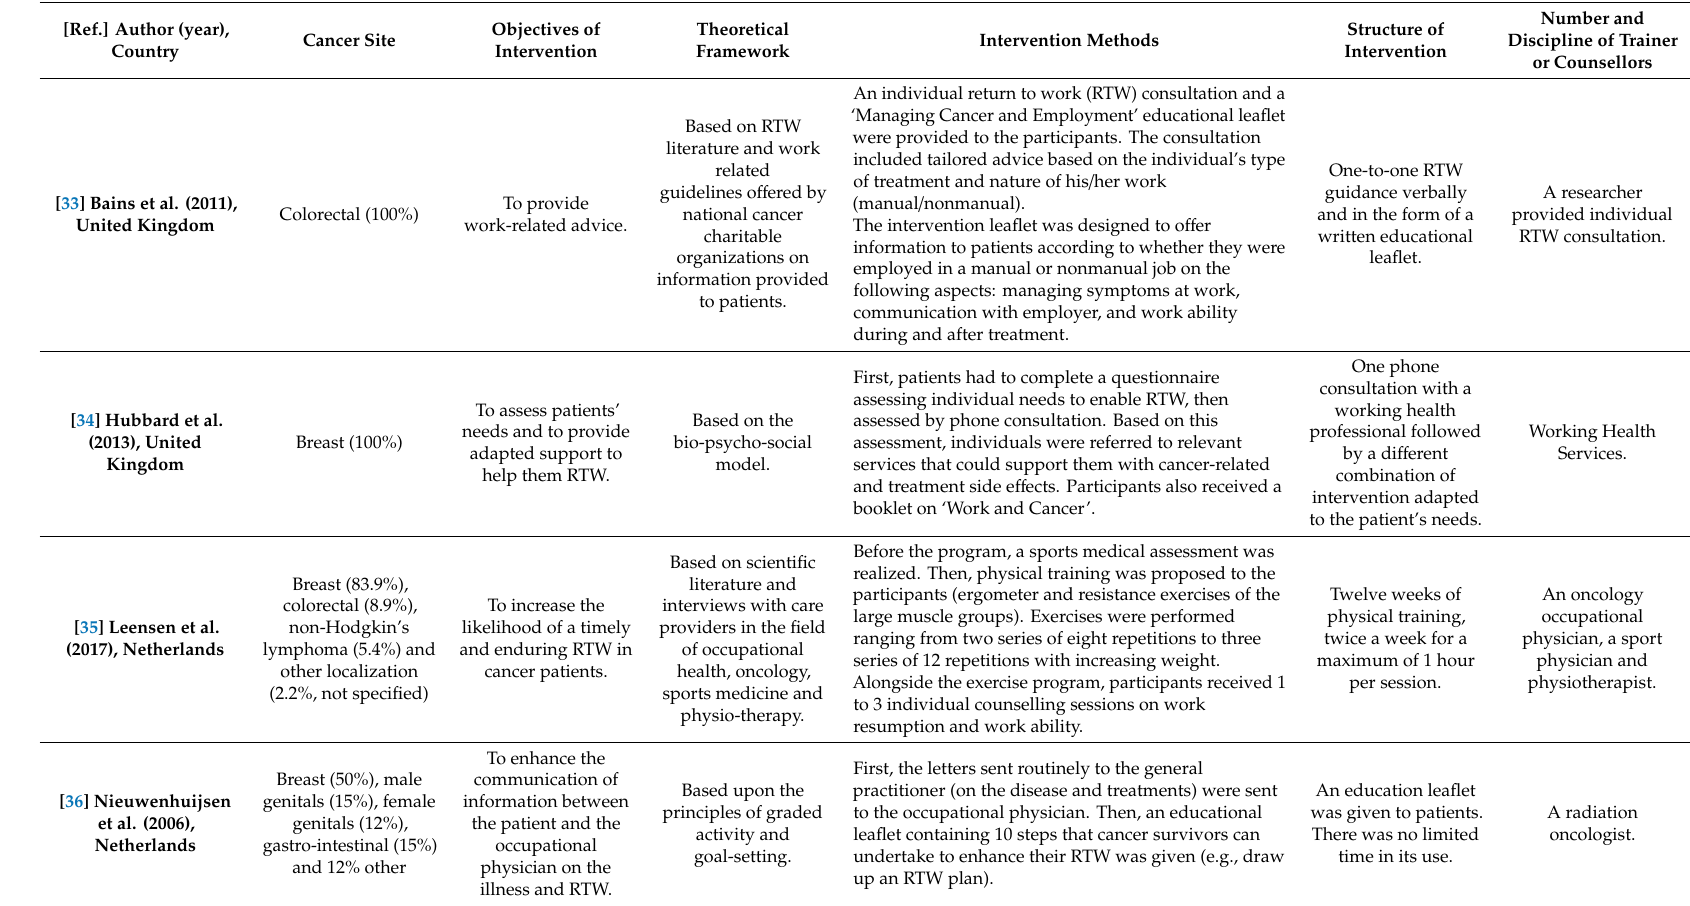
Table 3. Description of the interventions presented in the included